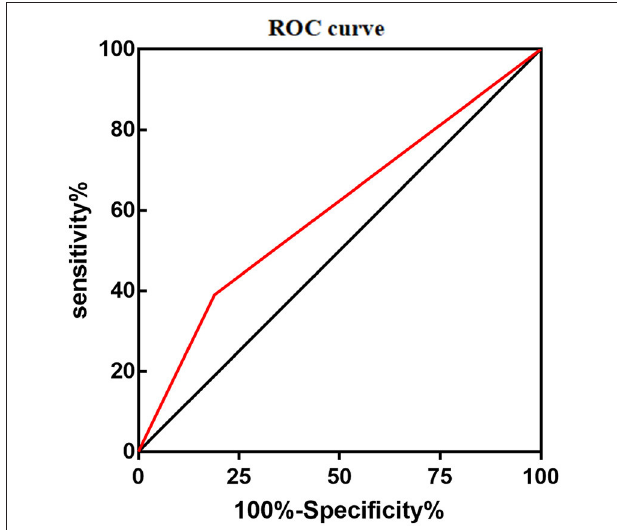
FIGURE 2 | Area under the curve (AUC) of NUDT15 c.415C > T predicting 6-MP dose decreased was 0.598.